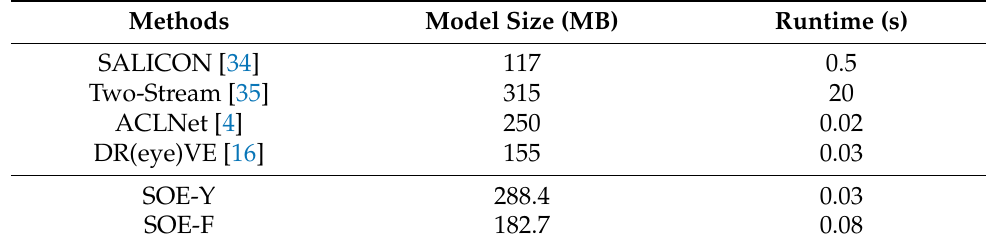
Table 3. Comparison of model size and runtime of SOE-Y and SOE-F with those of other